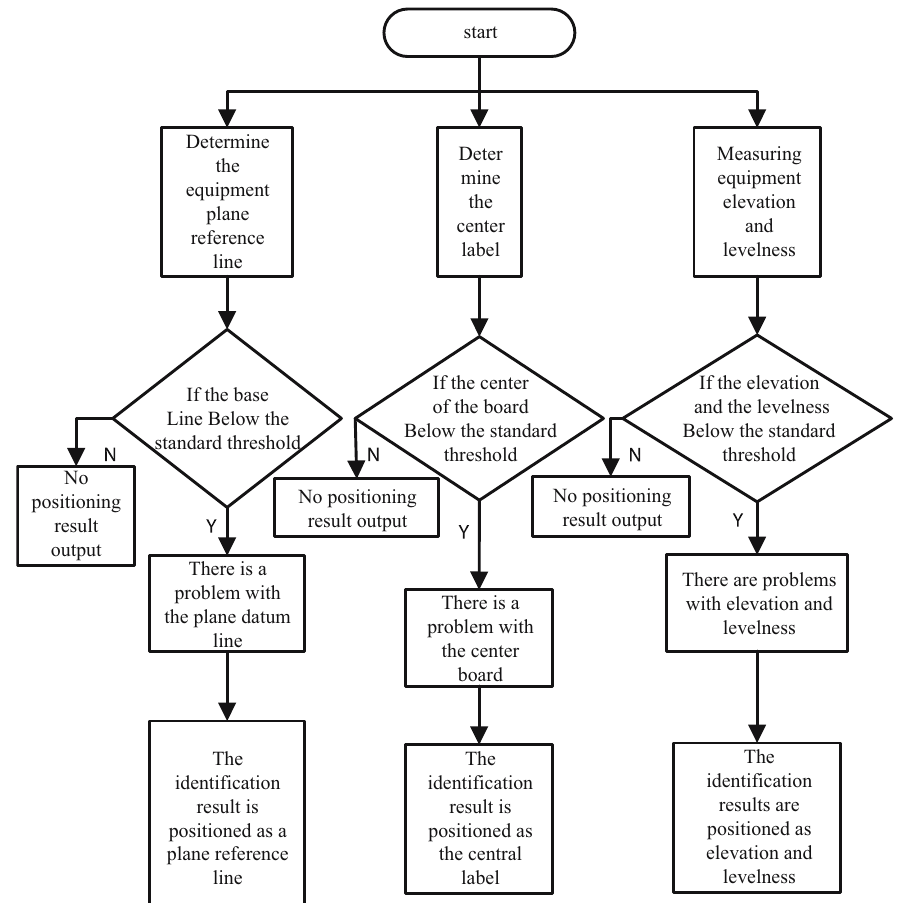
Figure 3: Equipment positioning and identi fi cation